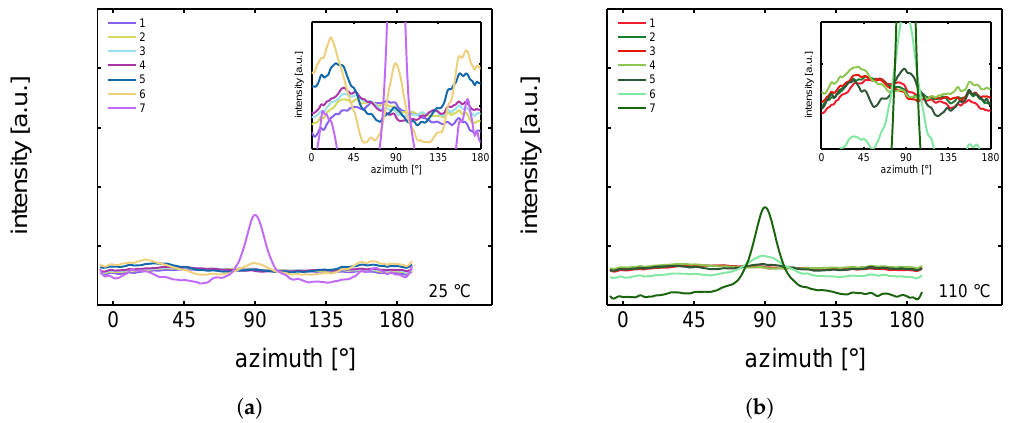
Figure 14. Azimuthal spread of the (300) diffraction of β -iPP at various strains. ( a ) uni-axial stretching at 25 ◦ C and ( b ) 110 ◦ C. The numbers in the legend correspond to the 2D patterns in Figure 13.